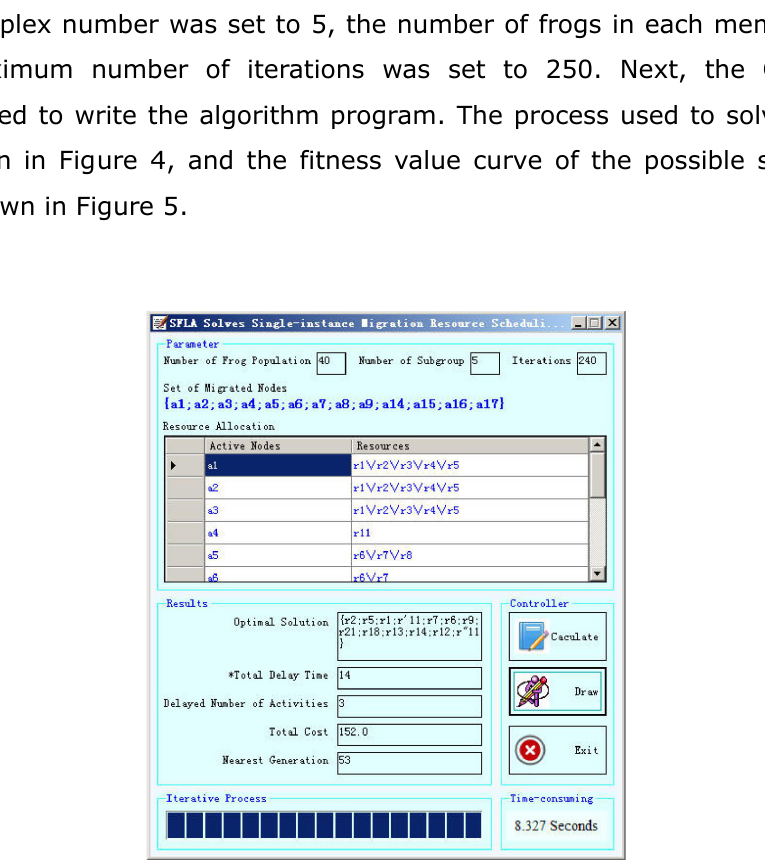
Figure 4. Resource scheduling optimization module for multi-instance migration